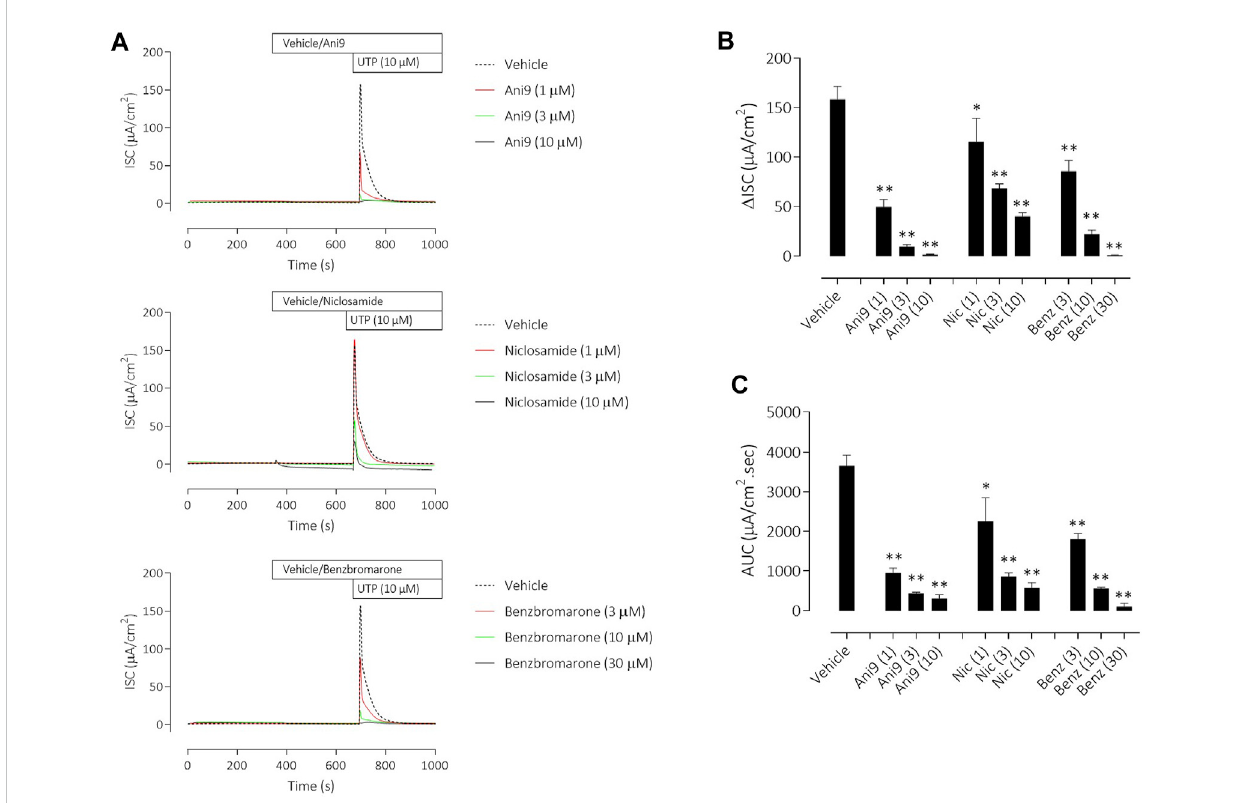
FIGURE 2 Ani9, niclosamide and benzbromarone attenuate UTP-stimulated anion secretion in FRT-TMEM16Aabc monolayers. Sample short-circuit current traces illustrating the effects of Ani9, niclosamide (Nic) and benzbromarone (Benz) on the apical UTP-stimulated response of FRT-TMEM16Aabc monolayers (A) . The peak increase in ISC (B) as well as the integrated AUC (C) were measured. Mean data ±SEM ( n = 8 – 11 inserts per group) are shown. Concentrations of test compounds are shown in brackets as µM. * and ** denote p < 0.0002 and p < 0.0001 respectively following a one-way ANOVA using post hoc Dunnett ’ s test.